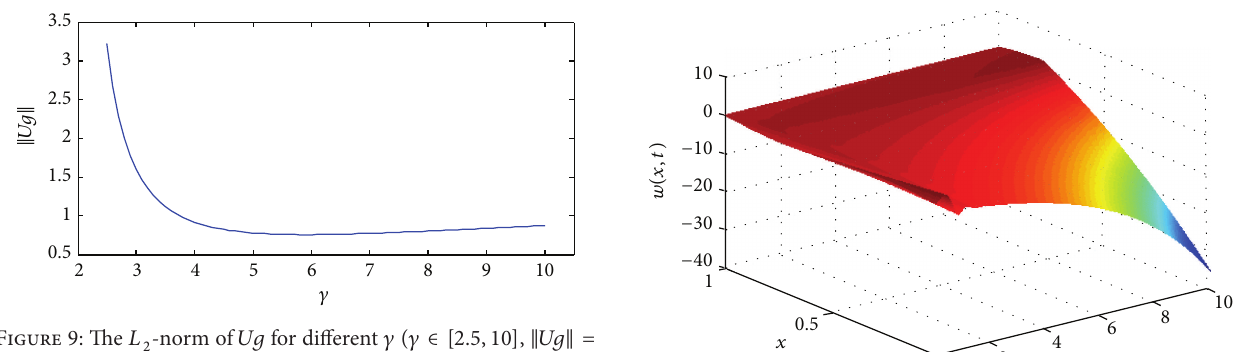
Figure 9: The 𝐿 2 -norm of 𝑈𝑔 for different 𝛾 ( 𝛾 ∈ [2.5, 10] , ‖𝑈𝑔‖ =